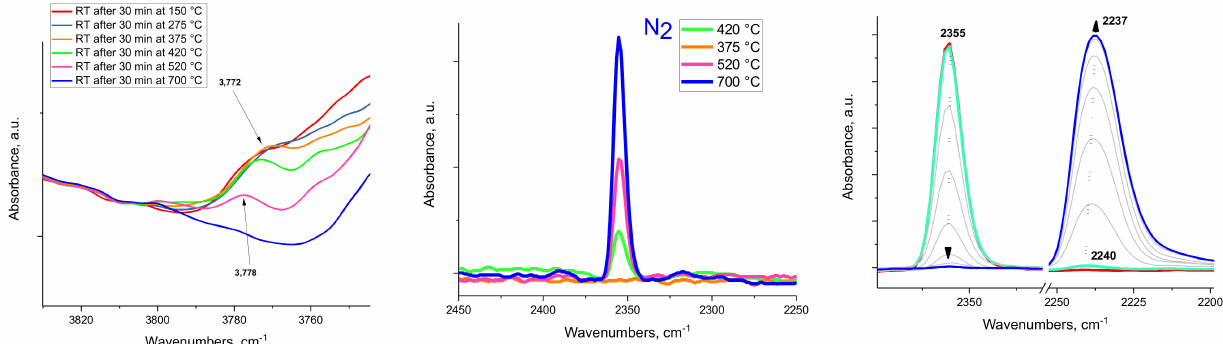
Figure 3. IR spectra for a rhombus-platelet gamma alumina sample. ( Left ) FTIR of the OH region showing a diminishment of the ~3780 cm − 1 band with an increase in temperature (spectra were recorded at room temperature after each treatment). ( Middle ) FTIR spectra collected after introducing a total of 5 Torr of nitrogen (total pressure; room temperature) on the alumina sample after each thermal treatment. The evolution of the N-N stretching band is due to N 2 adsorption on Al 1 O 5 dehydroxylated sites which only occurs when the specific OH band decreases from dehydroxylation taking place. ( Right ) Sequential CO adsorption on the sample containing a O 5 Al-N 2 complex: this establishes that CO displaces N 2 as a coordination site in the O 5 Al-CO complex. This complex has a CO stretch around ~2240–2236 cm − 1 , very similar to the surface Al 1 O 5 sites of dehydroxylated Al 2 O 3 clusters in zeolites. The spectra of dehydroxylation of SBA-200 and rod-like alumina samples are shown in Figure